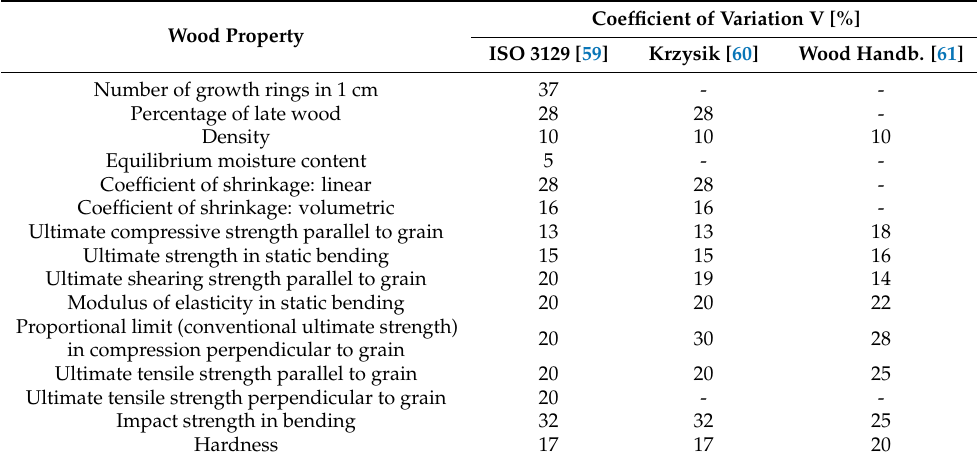
Table 4. Mean coefficient of variation [%] values for main wood